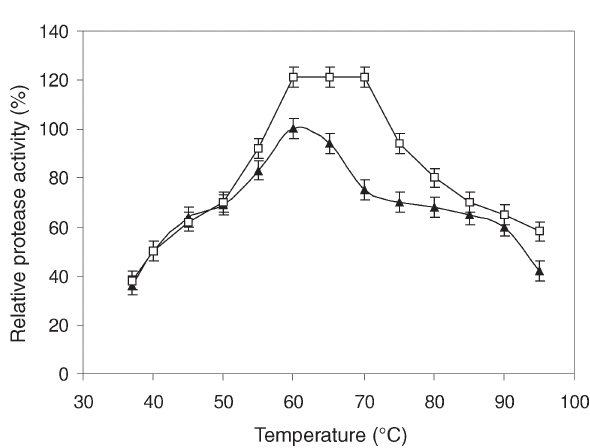
Figure 5. Effect of NaCl concentration on purified protease activity. Azocaseinolytic activity of protease was determined in 0.1 M gly- cine-NaOH buffer (pH 10.0) at 60 °C in the presence of the indicated concentrations of NaCl, after incubation for 15 min. Each point repre- sents the mean ± SE of three independent experiments.